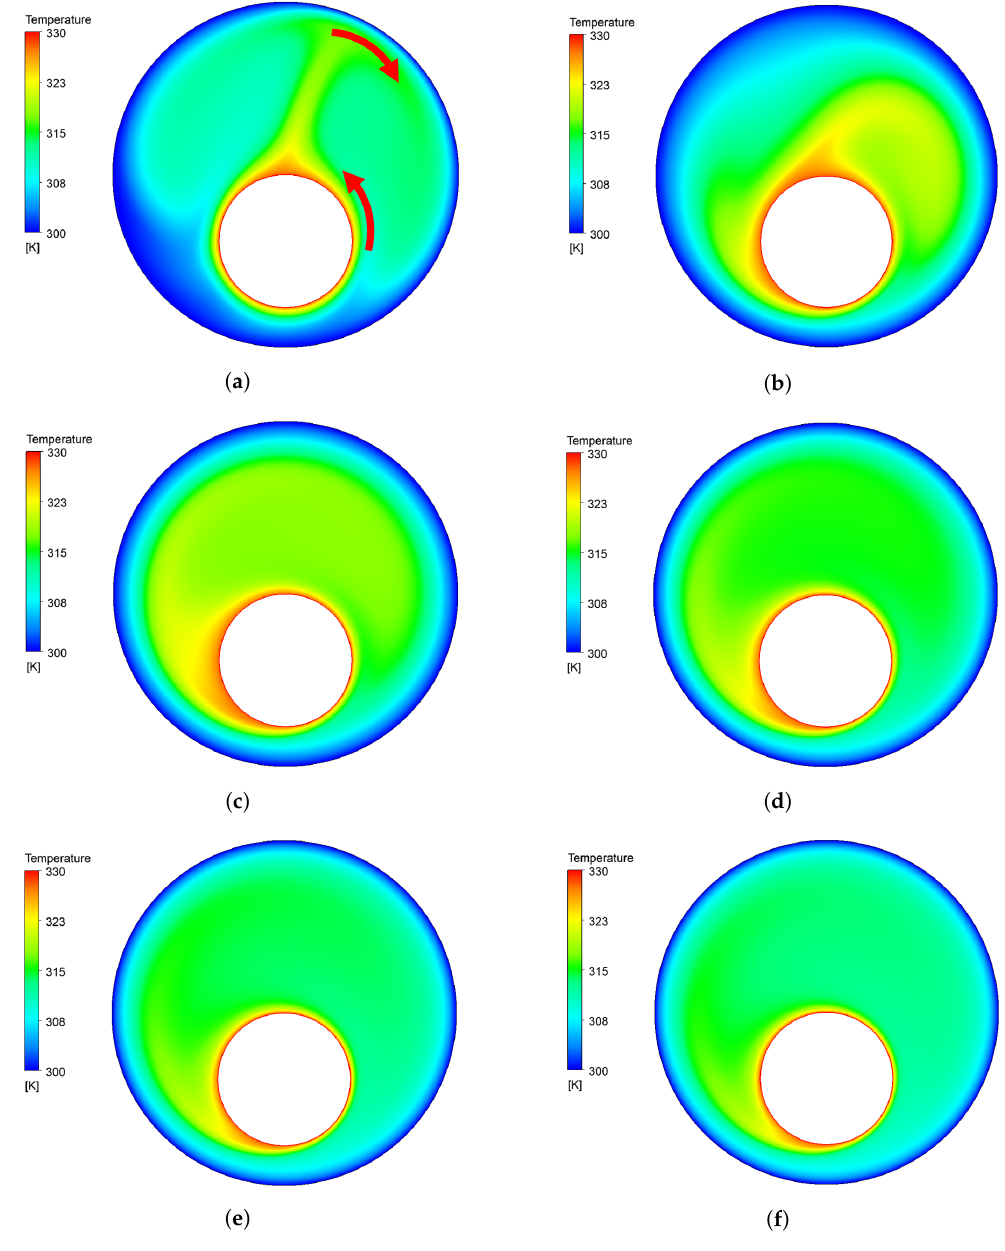
Figure 8. Numerical solutions for the inner clockwise, outer counterclockwise rotations with the same angular velocity: ( a ) 2 rad/s; ( b ) 5 rad/s; ( c ) 10 rad/s; ( d ) 15 rad/s; ( e ) 20 rad/s; and ( f ) 25